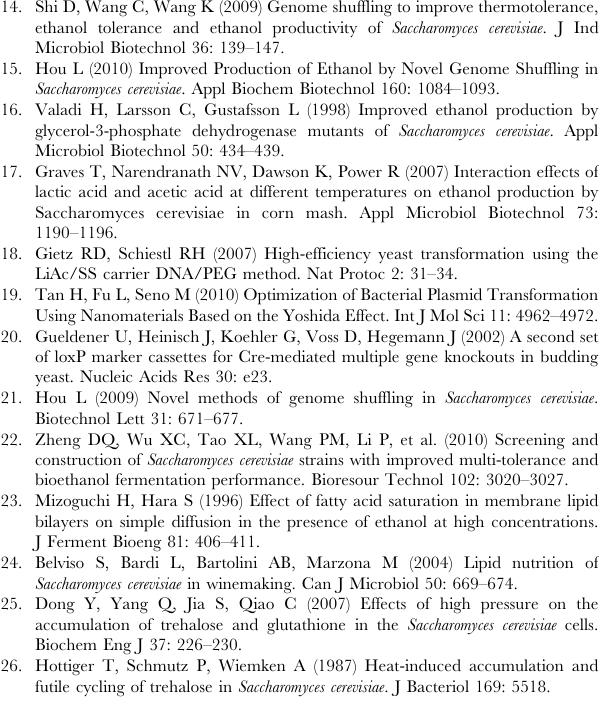
Figure S2 Comparison of DNA content of strains Z5 (red) and SZ3-1 (black) using flow cytometry. Table S1 Primers used for GPD2 deletion and TPS1 , TPS2 overexpression. Table S2 Oligonucleotides used for quantitative